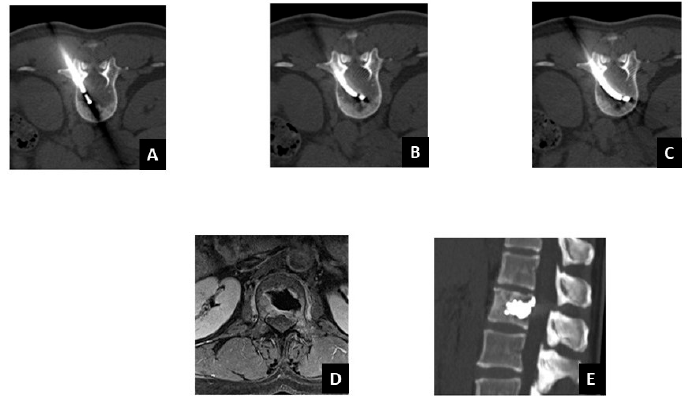
Figure 1. Limits of the use of conventional radiofrequency straight needles for the treatment of difficult-to-reach vertebral metastases. ( A ) Breast cancer metastasis in a 61-year-old patient. Axial CT scan shows a lytic lesion of in the posterior wall of the vertebral body L2 with cortical disruption. ( B ) Conventional RFA with straight needles is not able to ablate the entire lesion (white triangle).